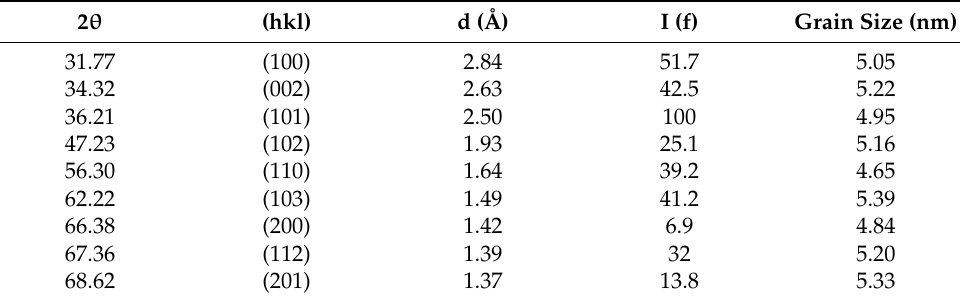
Table 1. Details of ZnO XRD characterization information.